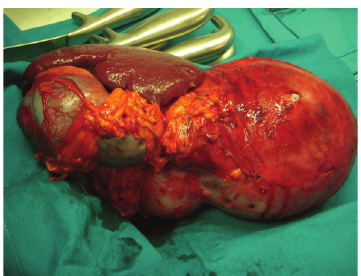
Figure 4: Intraoperative finding—en bloc resection of the mass with the tail of the pancreas and the spleen.